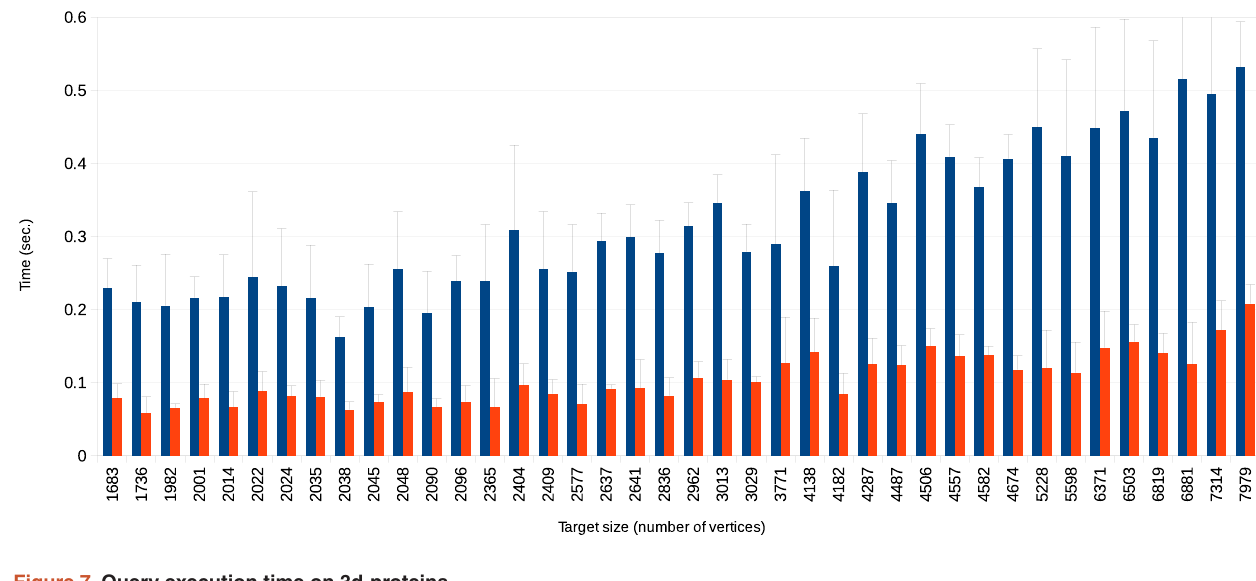
4, 8, 16, 32, and 64 and density from low to high (up the 90% of edges among nodes are present). Figure 7 evaluates NetMatchStar on protein back-bones graphs. They are large sparse graphs. The original labels are maintained since they are not unique (i.e., atoms names). Figure 8 evaluates NetMatchStar on contact map graphs. They are dense medium graphs. The original labels are maintained since they are not unique (i.e., amino